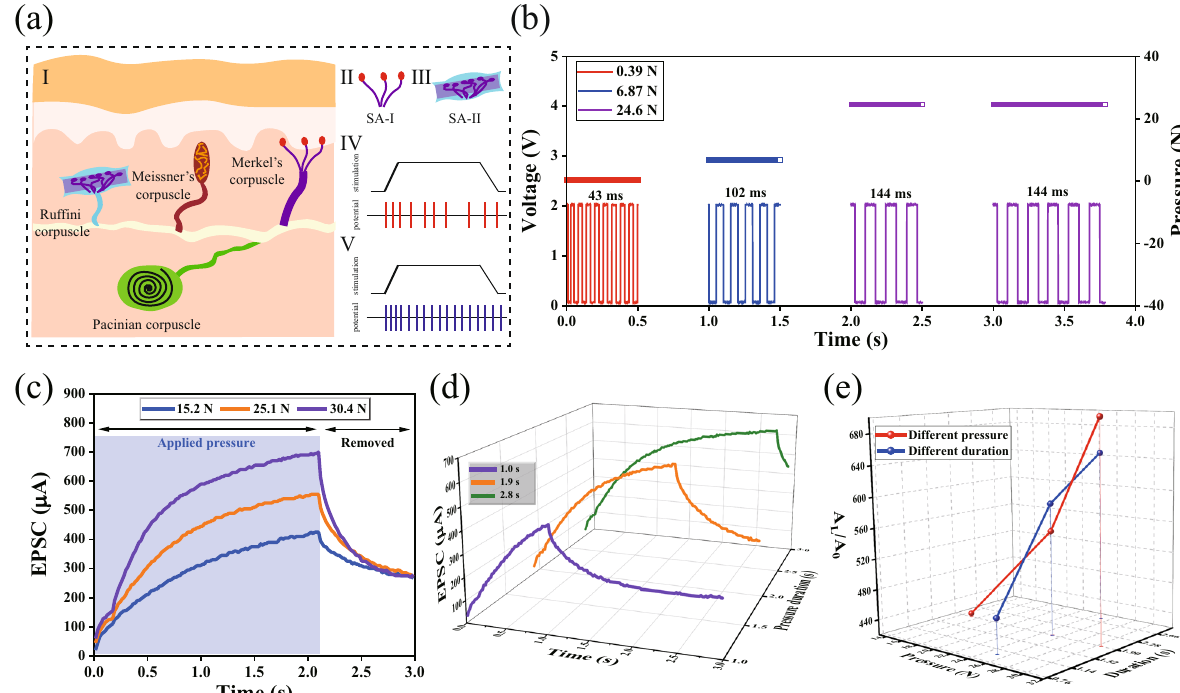
Fig. 3 The temporal information-processing function of the arti fi cial system. a Schematic diagram of the function of slow adapting receptors. b The output voltage-pressure curve of the oscillator triggered by the fl exible tactile sensor, indicating the pulse frequency can be modulated by the applied force. Line with different colors correspond to the magnitude and duration of pressure, I, II, III, and IV correspond to (0.39 N, 0.5 s), (6.87 N, 0.5 s), (24.6 N, 0.5 s), and (24.6 N, 1 s), respectively. c The postsynaptic current curves of the fl exible synaptic transistor connecting with the fl exible tactile sensor and oscillator under different magnitude of pressure, indicating that our system can achieve the EPSC functions triggered by different pressure. The blue, orange and purple curves represent the magnitudes of the pressure of 15.2, 25.1, and 30.4 N, respectively. d The EPSC curves of our fabricated systems under various pressure durations with the same magnitude of 25.1 N, indicating that the EPSCs increasing with the pressure durations. The purple, orange, and green curves indicate the duration of the pressure of 1, 1.9, and 2.8 s, respectively. e The ratio between the maximum value and the initial value of I post for different pressure magnitudes and